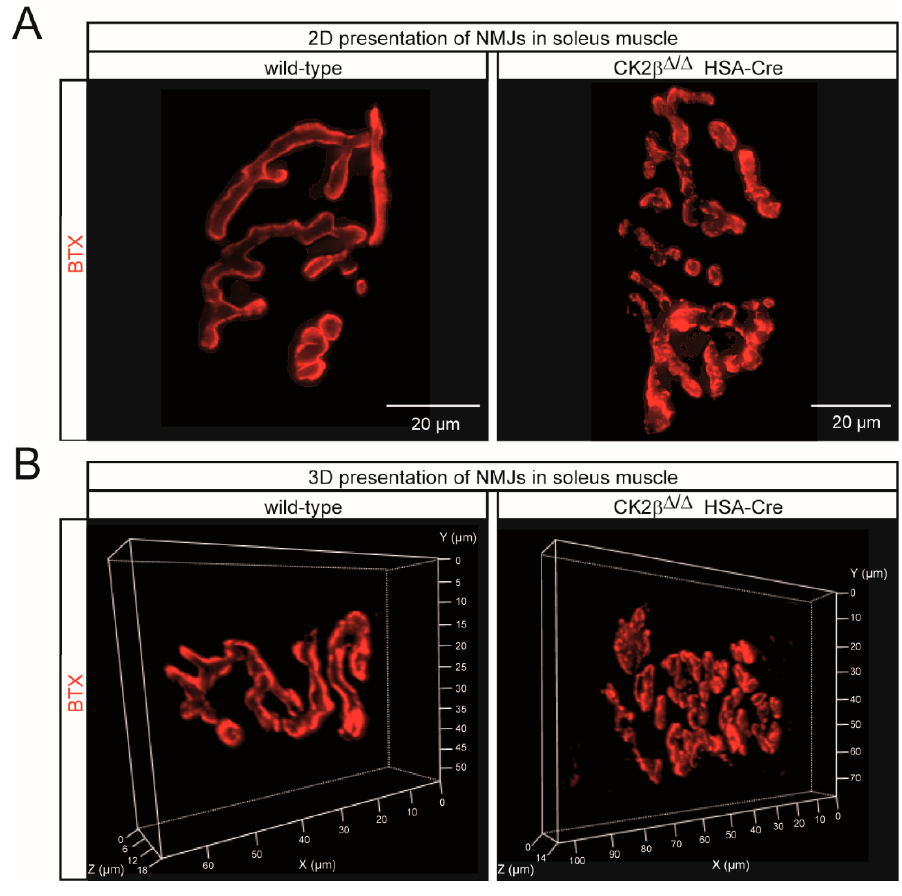
Figure 5. Conspicuous morphological alterations were visible at the NMJs of CK2 β -deficient skeletal muscles. ( A , B ) Representative 2D ( A ) and 3D ( B ) images of whole-mount stainings of wild-type and CK2 β -deficient soleus muscle after BTX staining (red) showing the presence of irregular and fragmented NMJs in CK2 β -deficient muscles. Scale bar, 20 µm.